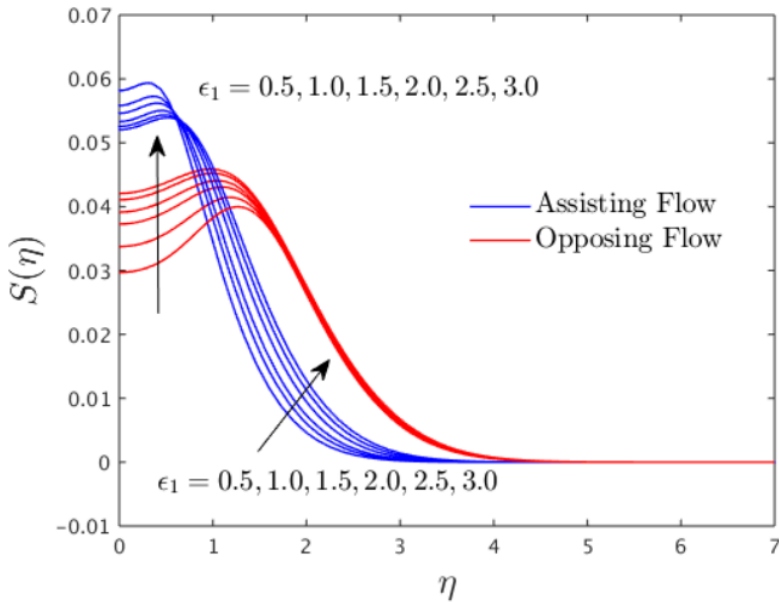
Figure 3.   G  against 1  . Figure 3. G ( η ) against ε 1 .